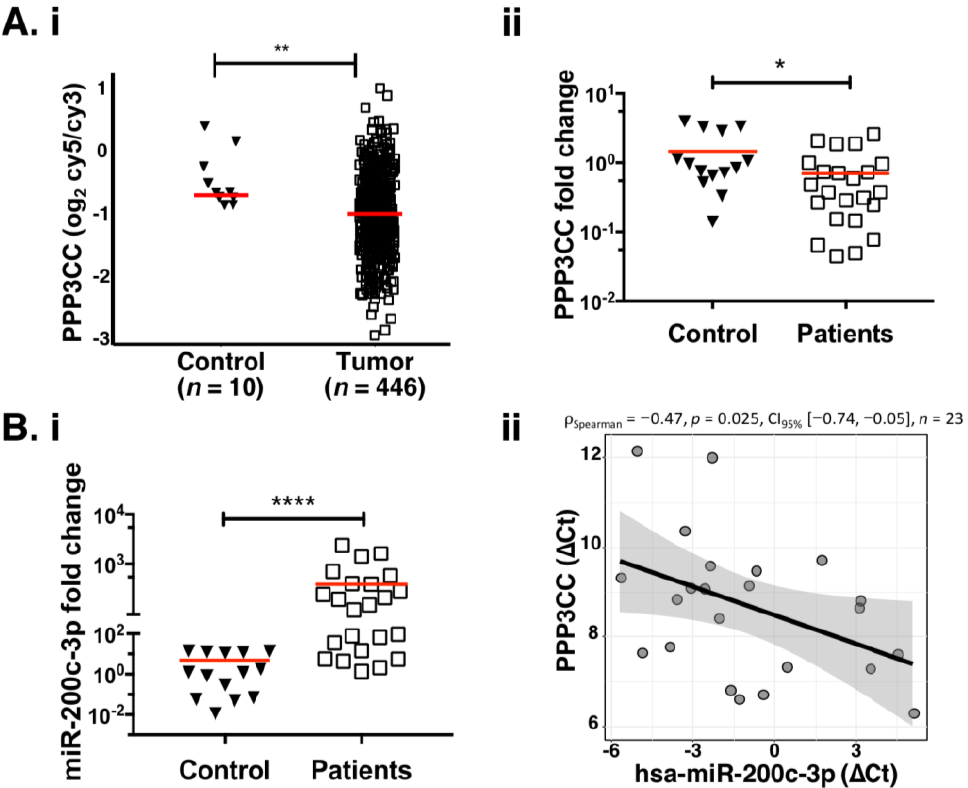
Figure 2. Overall increase in miR-200c-3p and decrease in PPP3CC expression in OC patients. ( Ai ): Expression of PPP3CC in 446 OC sample tissues compared to 10 normal ovarian tissues from TCGA. Log2 lowess normalized ratio of sample signal to human reference RNA signal (Cy5/Cy3) from microarray measurements are reported. ( Aii ): Expression of PPP3CC in 23 patients (white boxes), compared with 14 normal OC biopsies (black arrowheads). The red line represents the mean value of PPP3CC expression in each group. ( Bi ): Expression of miR-200c-3p in the same cohort (controls and patients) as in ( Aii ). ( Bii ): Anticorrelation analysis of miR-200c-3p and PPP3CC in the 23 patients. Spearman’s rank correlation coefficient was equal to − 0.47 with p -value 0.025. For all the pairwise comparisons, a two-tailed unpaired t -test was applied for statistical significance. * p < 0.05, ** p < 0.01, **** p < 0.0001.